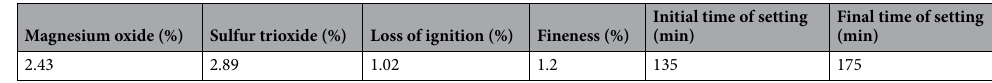
Table 2. Chemical, physical and mechanical properties of 42.5 Portland cement.